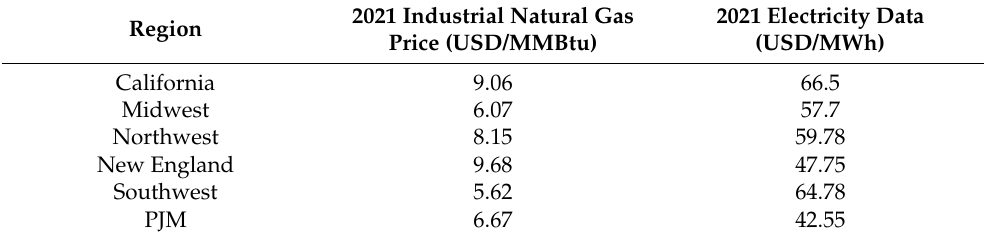
Table 2. Utility Data for Different Regions.